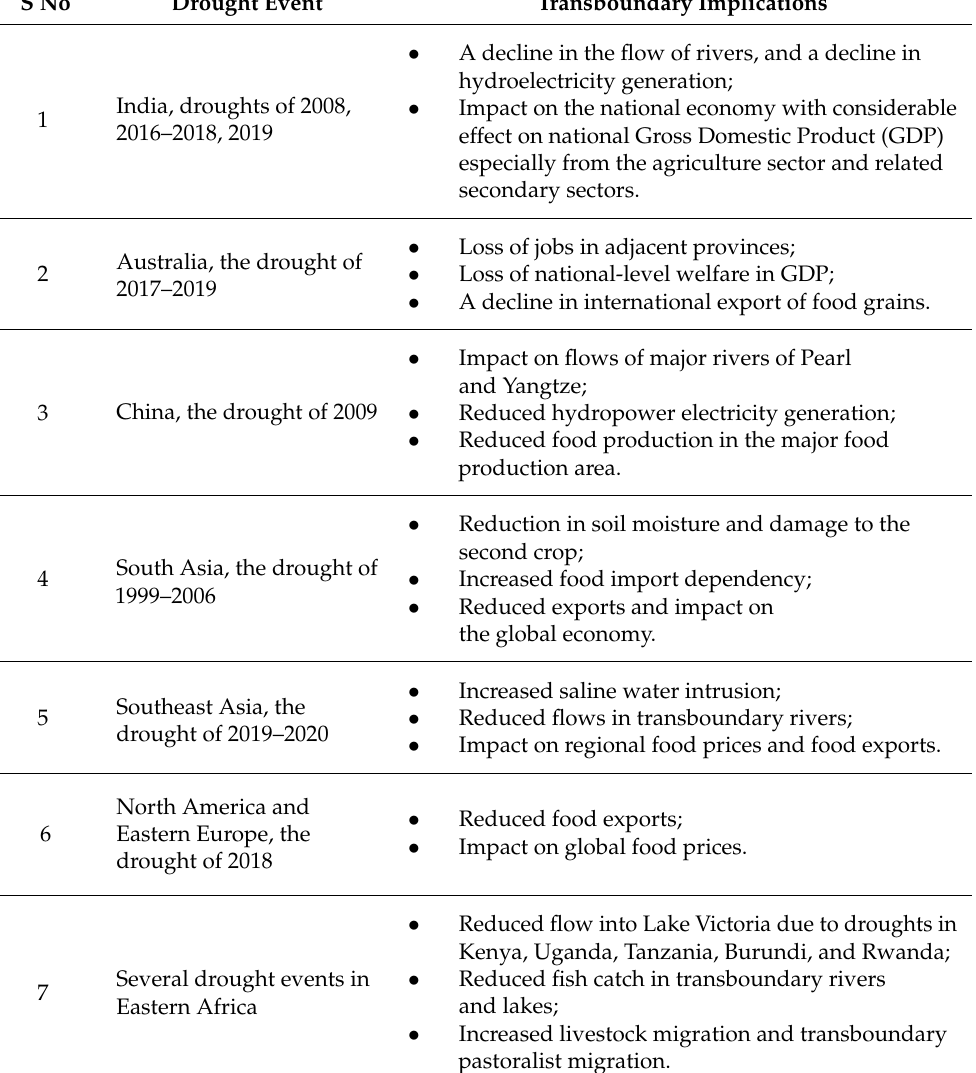
Table 1. Regional droughts and other events with transboundary risk